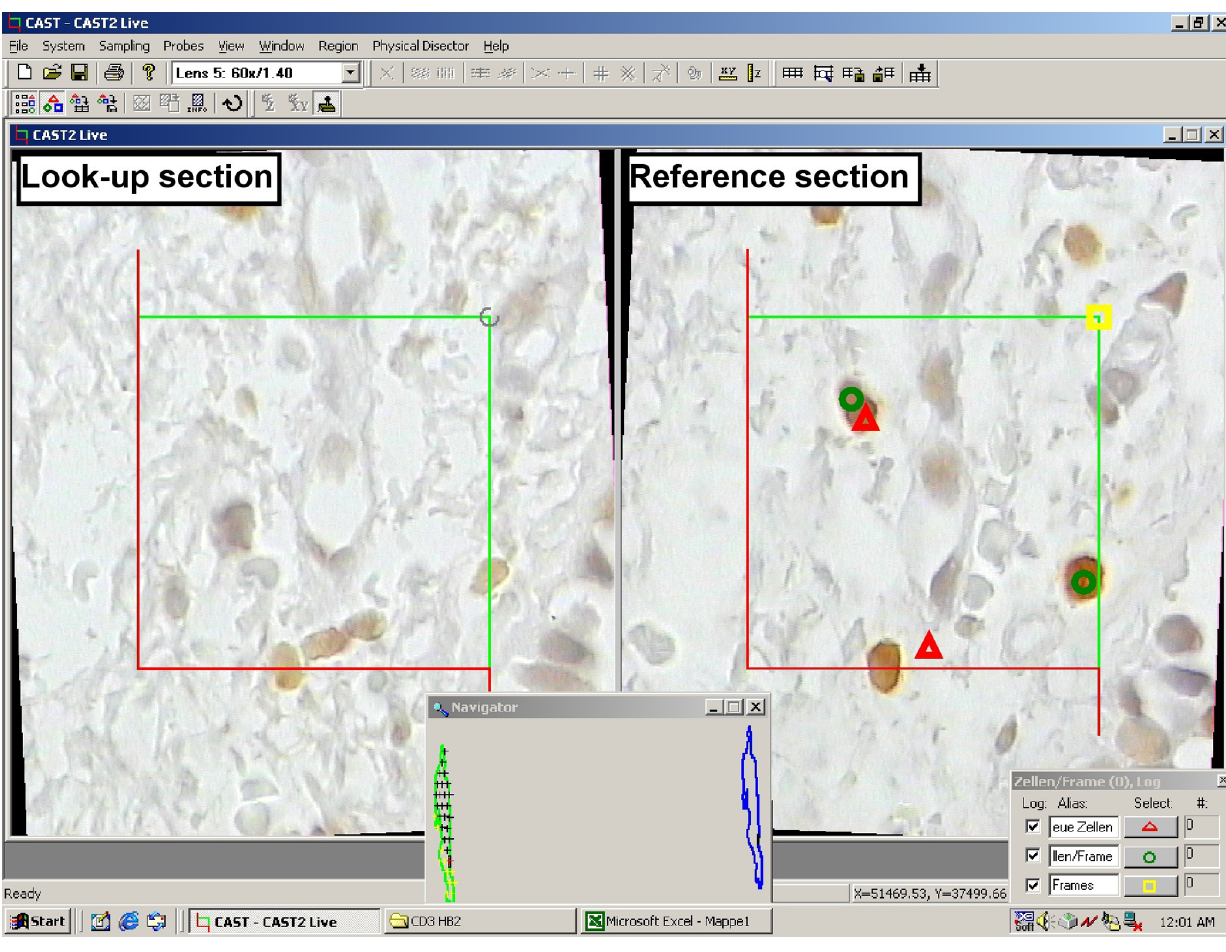
Figure 2. Physical disector (3D) and profile counting (2D) within a consecutive reference and look-up section. Red triangles mark cell profiles seen in the reference section which are not present in the look-up section (bidirectional counting); green circles mark all cell profiles seen in the right section; yellow squares mark each assessed counting frame/field of view. The cell profile cutting the lower exclusion (red) line is not counted either in 3D or in 2D.